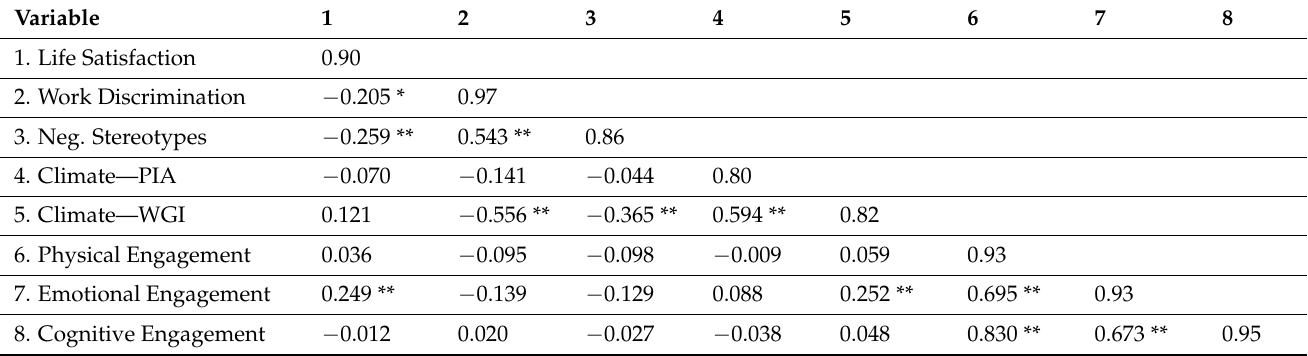
Table 1. Correlations among the variables (numbers vary between 115 and